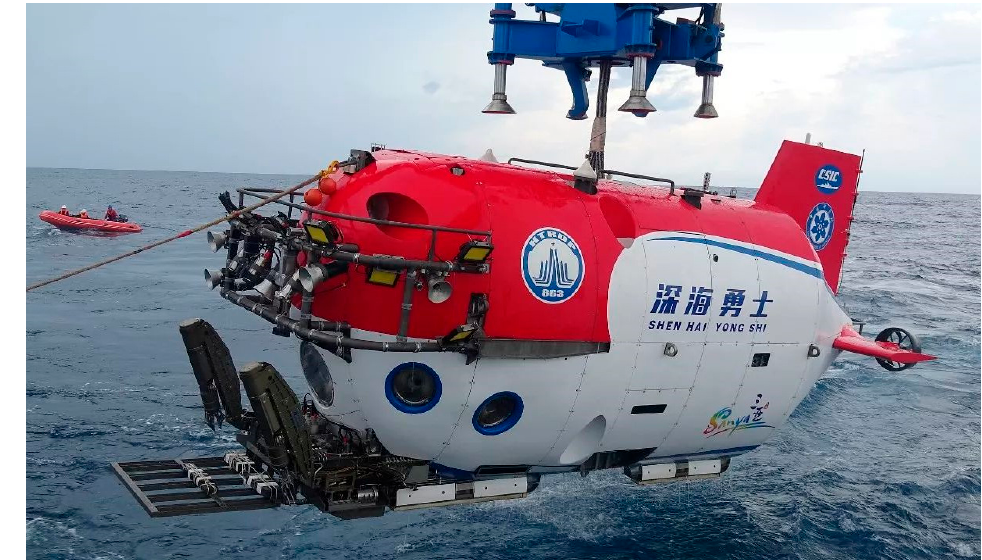
Figure 7. The HOV ‘SHEN HAI YONG SHI’. Table 1. Specifications of the HOV.